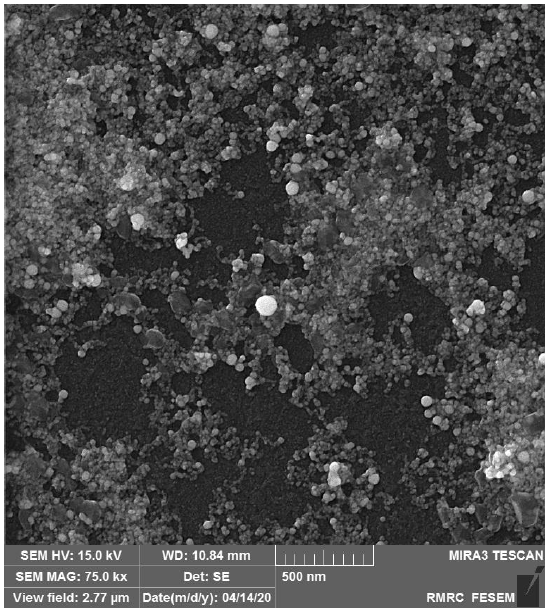
Figure 3. SEM image of Au nanoparticles.